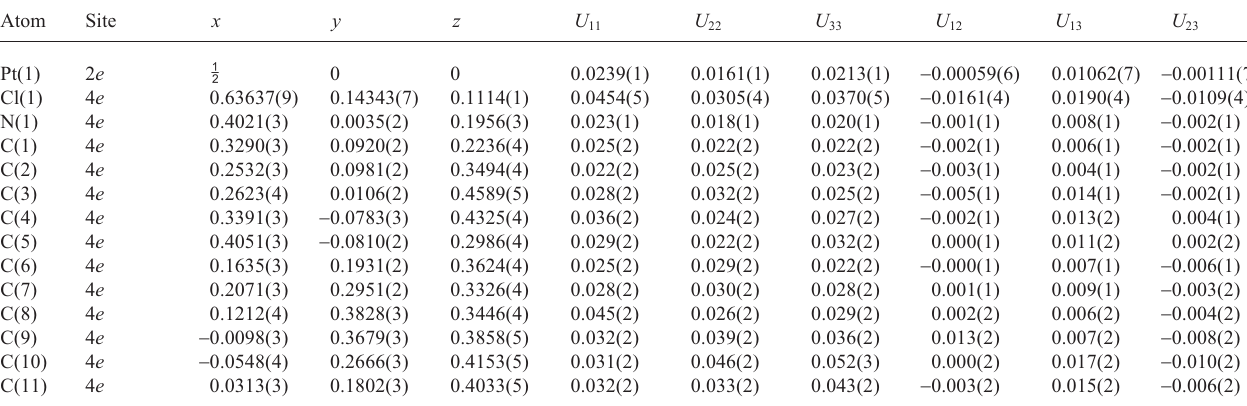
Table 3. Atomic coordinates and displacement parameters (in Å 2 )